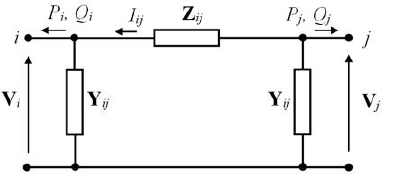
Π model of power line i–j . Z Figure A1. The assumed  model of power line i – j . Z ij = r ij + j x ij , Y ij = j 0.5 b ij . Figure A1. The assumed